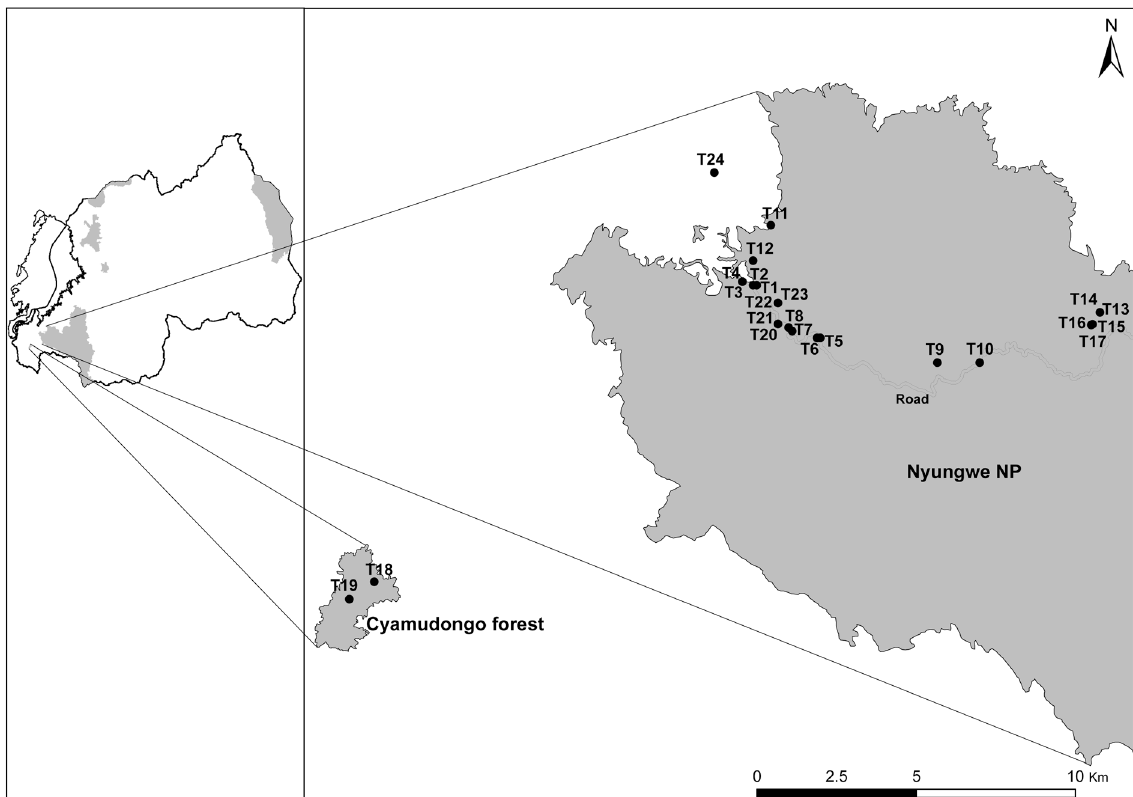
Fig. 1. Map of Rwanda (left) with indication of the position of the study area and the distribution of the sampling sites (right)